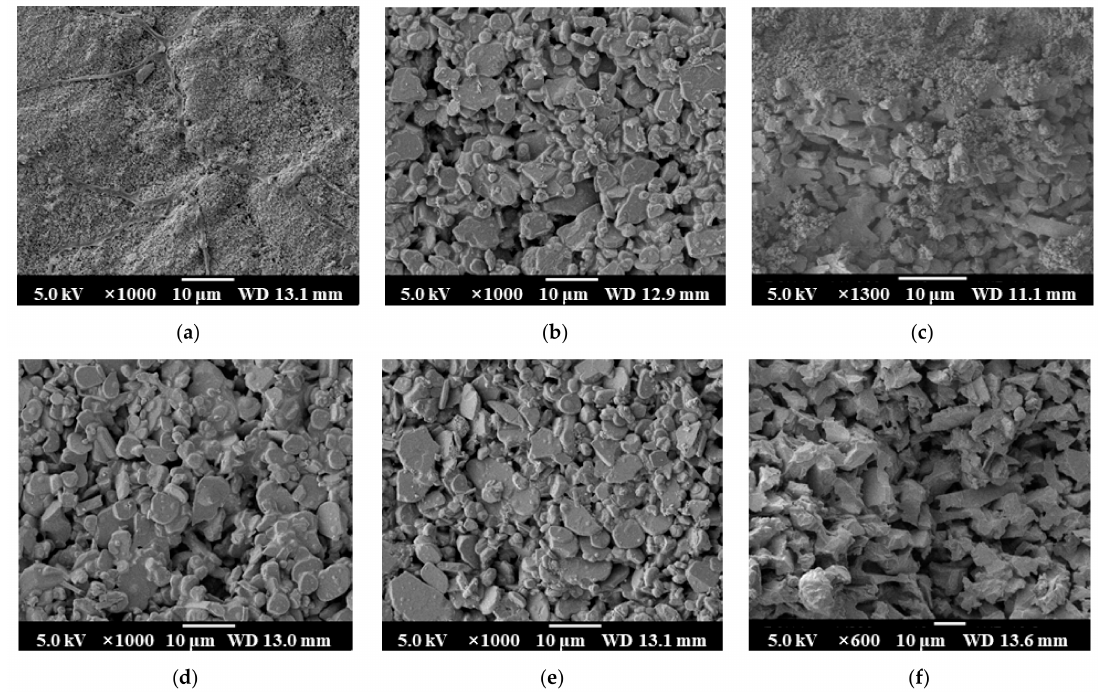
Figure 3. SEM image of ceramic membrane sample. ( a ) 10 nm membrane outside surface; ( b ) 10 nm membrane inside surface; ( c ) 10 nm membrane truncation surface; ( d ) 1 µ m membrane outside surface; ( e ) 1 µ m membrane inside surface; ( f ) 1 µ m membrane truncation surface.